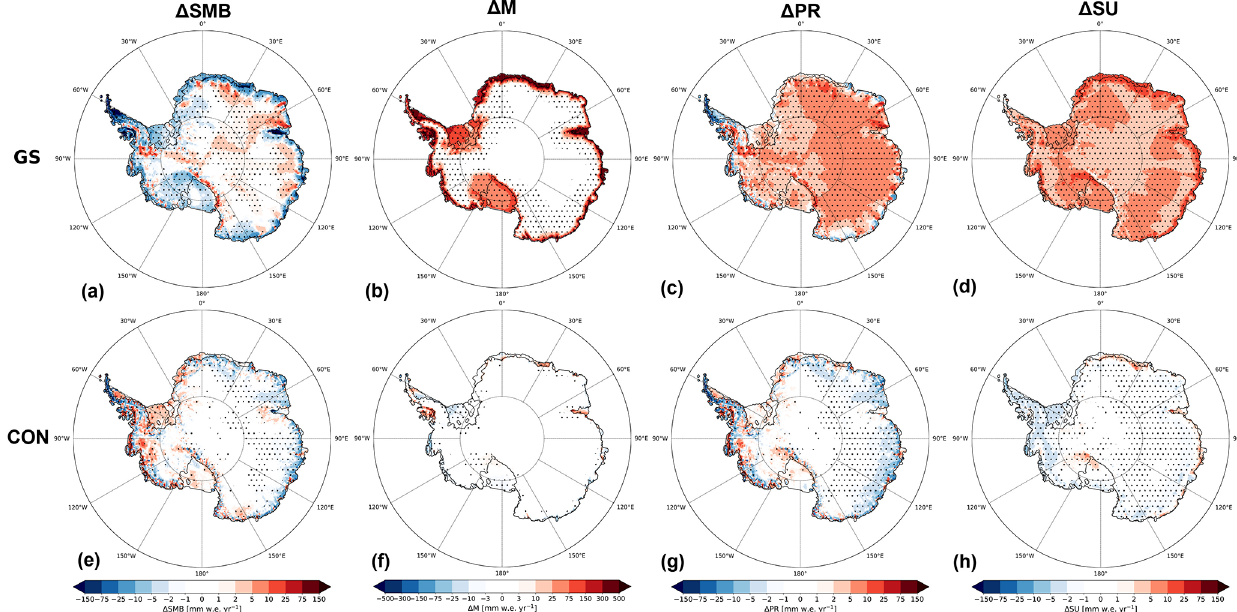
Figure 10. Yearly accumulated SMB, melt (M), precipitation (PR) and sublimation (SU) difference with Rp2 for GS ( a – d , respectively) and CON ( e – h , respectively) for 1985–2018, with positive values showing an increase with respect to Rp2. Runoff and drifting snow erosion are not shown. The dots represent significance.